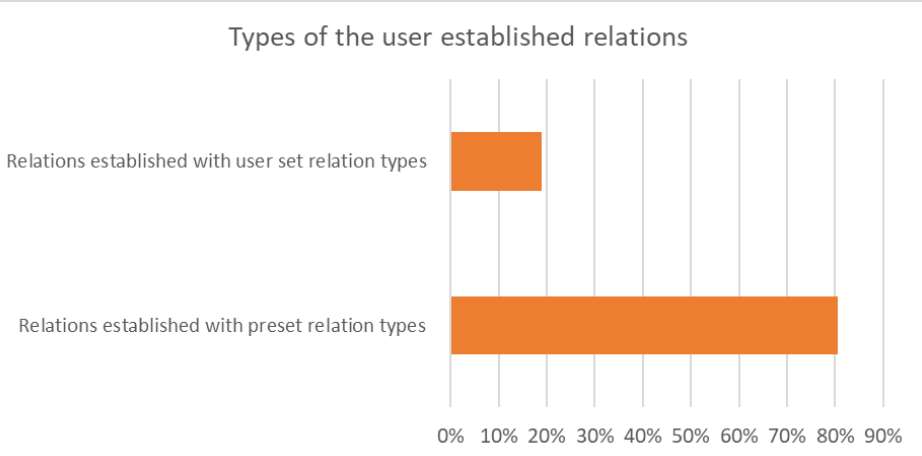
Figure 10. Information about the user established relations.